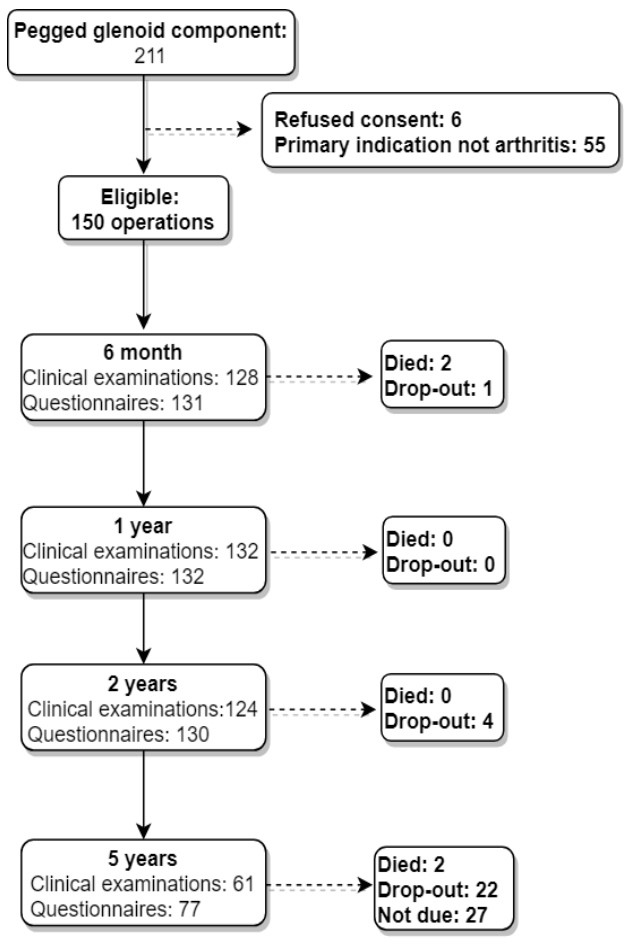
Figure 2. Study flow-chart.